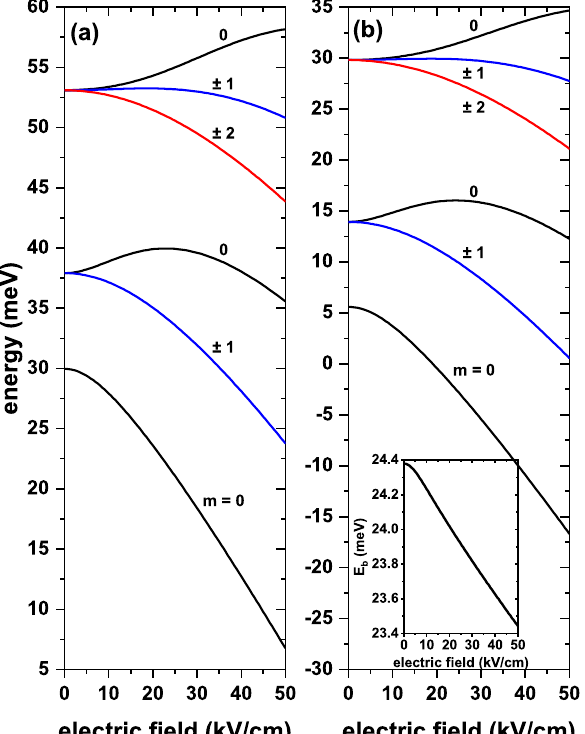
Figure 4. The lowest electronic states in a ZnS/CdS/ZnS spherical core/shell/shell quantum dot as functions of the applied electric field. In ( a ), results are presented without, and in ( b ) with on-center donor impurity effects, with R 1 = 4 nm, R 2 = 11 nm, and R 3 = 12 nm. Different values of the m -quantum number and without external magnetic field effects have been considered. Labels above each of the curves give the values of the m -quantum number. The inset in ( b ) corresponds to the ground state (the lowest state with m = 0) binding energy as a function of the applied electric